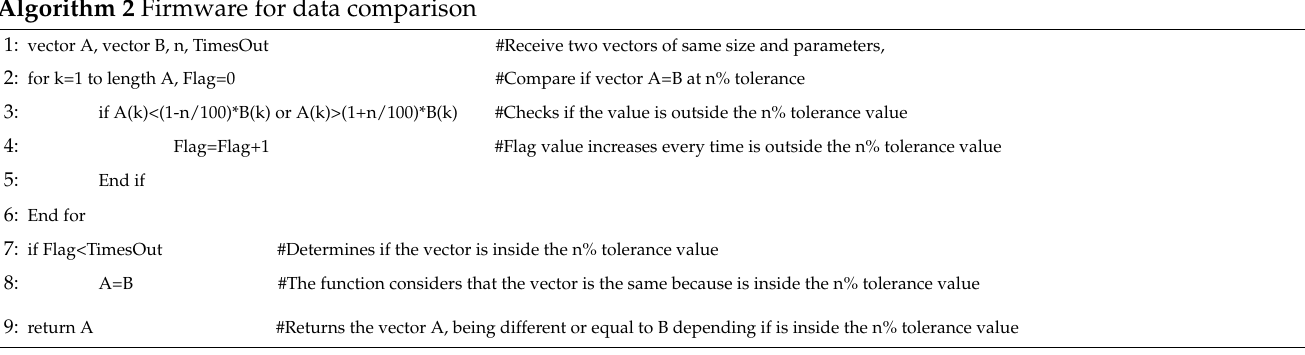
Algorithm 2 Firmware for data